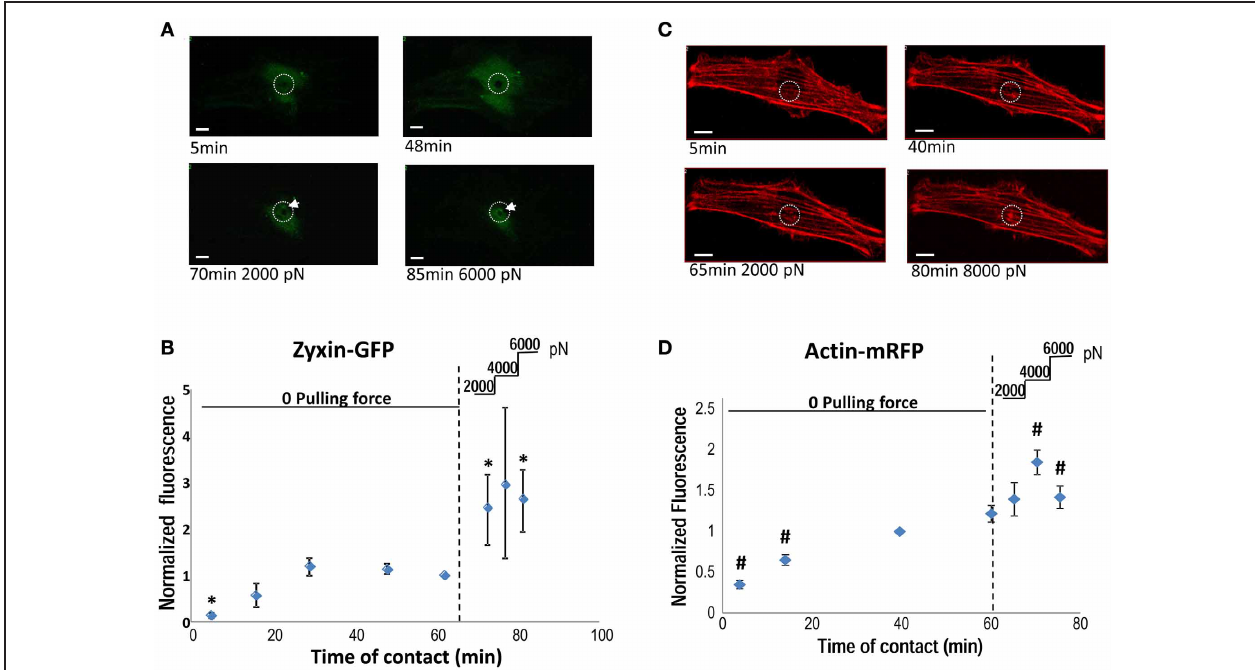
FIGURE 2 | (A) Accumulation of zyxin-GFP around a FN-coated microsphere (10 μ m) applied on the VSMC surface using AFM. FN-bead AFM probes were engaged to cell surface for 65min before pulling forces were applied stepwise (2000pN/step). The white circle illustrate the position of FN-bead, and white arrow pointing to the zyxin clustering. (B) The time course of zyxin-GFP recruitment to the FN-bead adhesion site quantified as normalized fluorescence intensity. (C) Accumulation of actin-RFP around a FN-coated microsphere (10 μ m) applied on the VSMC surface using AFM. The white circle illustrate the position of FN-bead. (D) The time course of actin-RFP